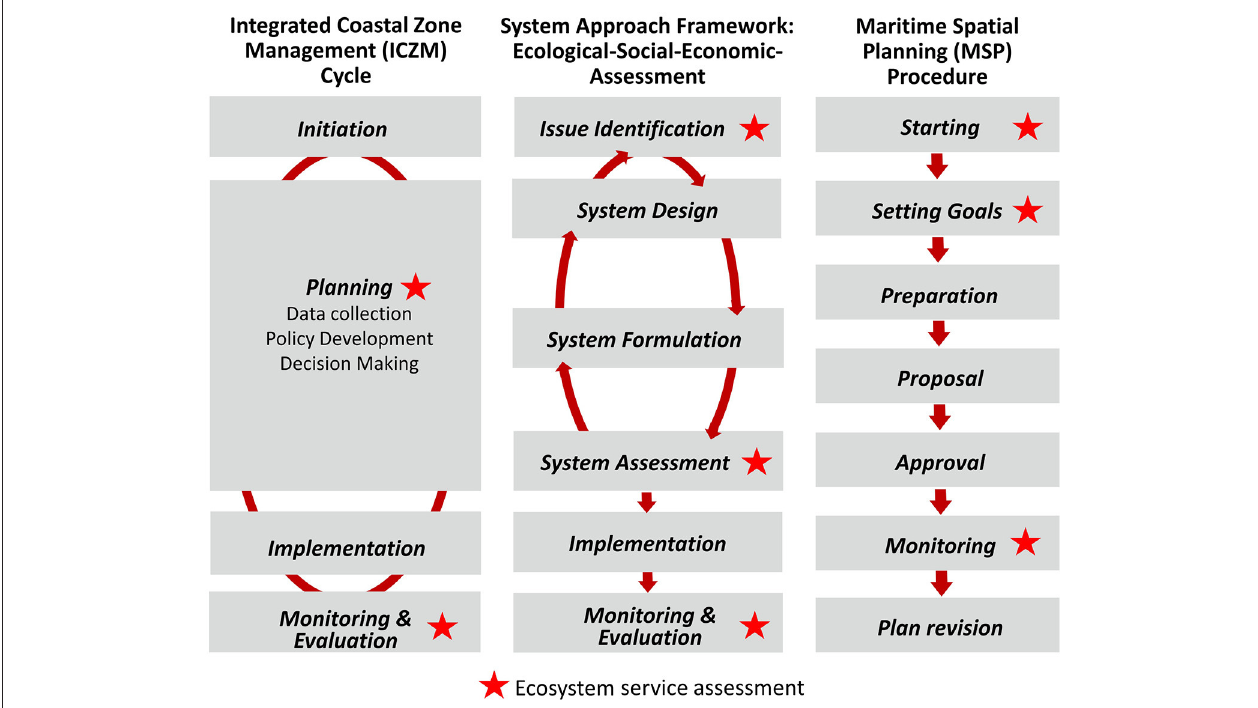
FIGURE 8 | The potential role of ecosystem service assessment in Integrated Coastal Zone Management (ICZM) and Systems Approach Frameworks (SAF) as well as in Marine Spatial Planning (MSP) (according to HELCOM-VASAB,